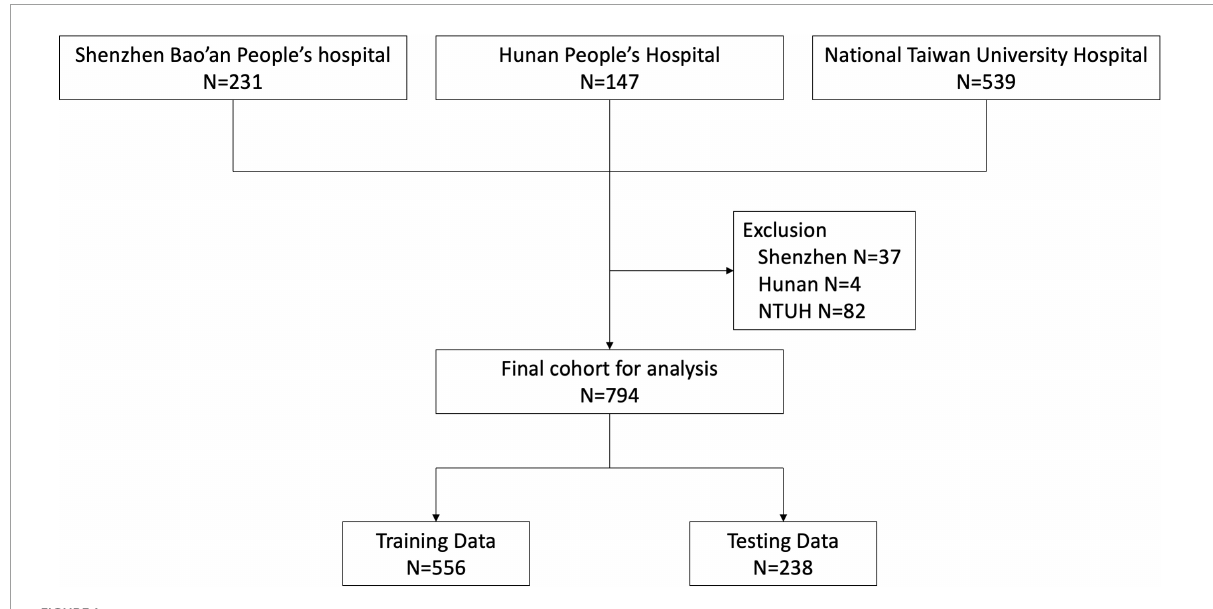
FIGURE1 Flowchart of patient inclusion and